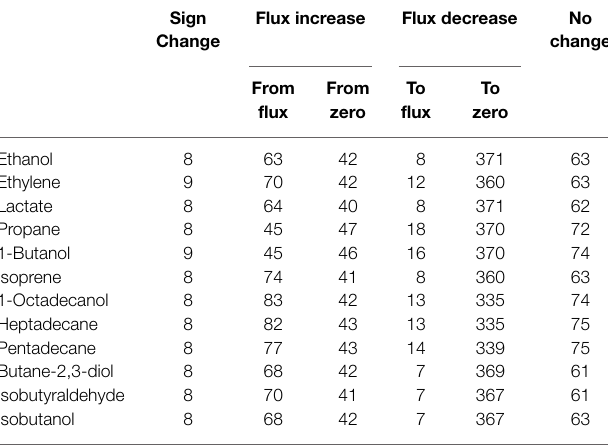
TABLE 2 | Metabolic transitions from cellular growth to product formation .